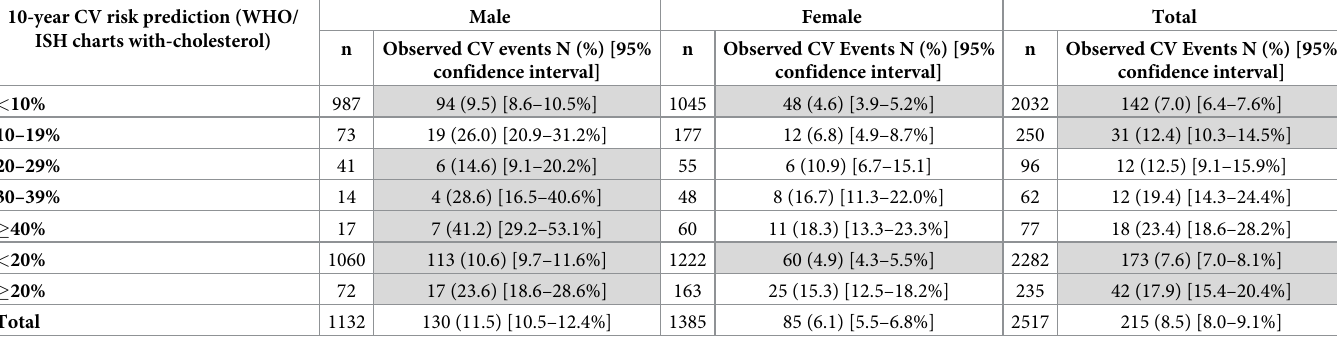
Table 4. Validation of WHO/ISH (SEAR B) risk prediction charts with cholesterol over 10 years. 10-year CV risk prediction (WHO/ ISH charts